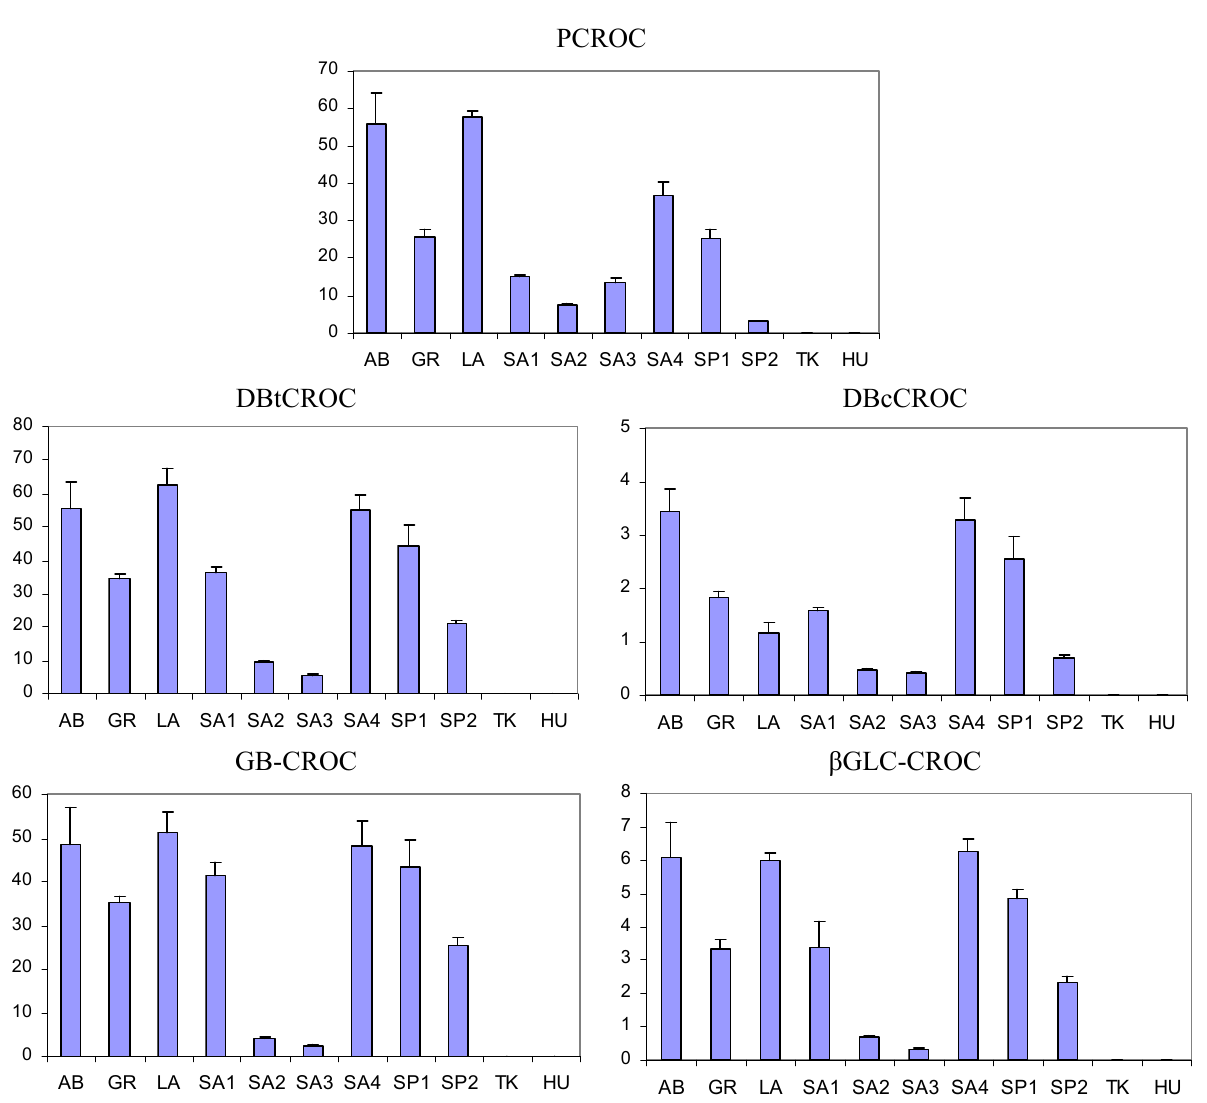
Figure 4. Histograms relative to the intensity of the selected metabolites (arbitrary units); see Tables 1 and 2 for the abbreviations. Mean values and standard deviations for each metabolite are